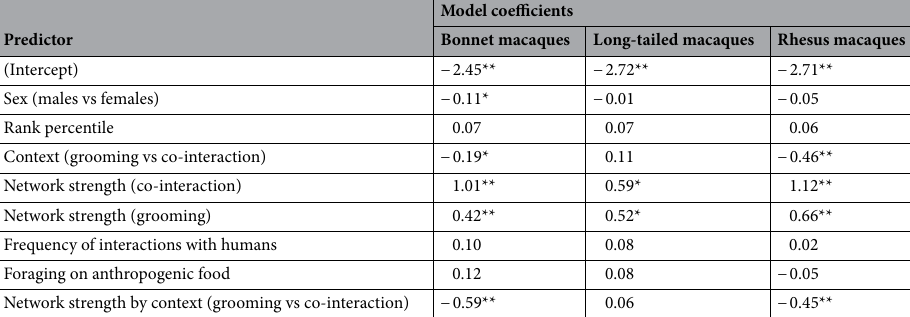
Table 1. Standardized model coefficients from the GLMMs (full model parameters in Supplementary Table 2) that examined the effects of context (co-interaction vs grooming), network strength centrality of the first-infected macaque, and the interaction between context and centrality, for each macaque (host) species. *p < 0.05; **p < 0.01.